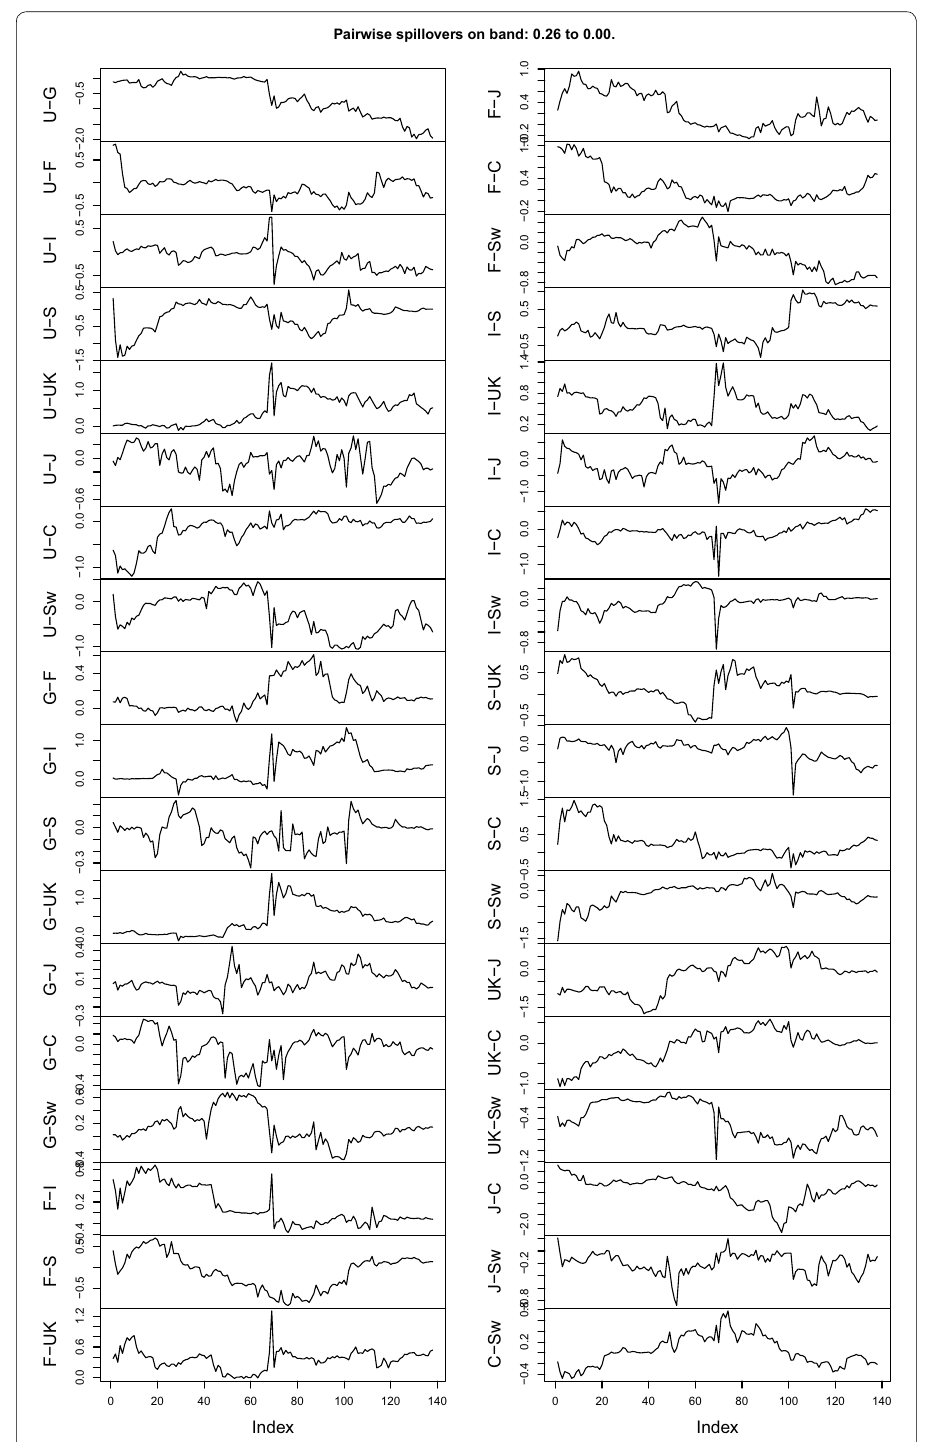
Fig. 16 10y12m—BK 12 months